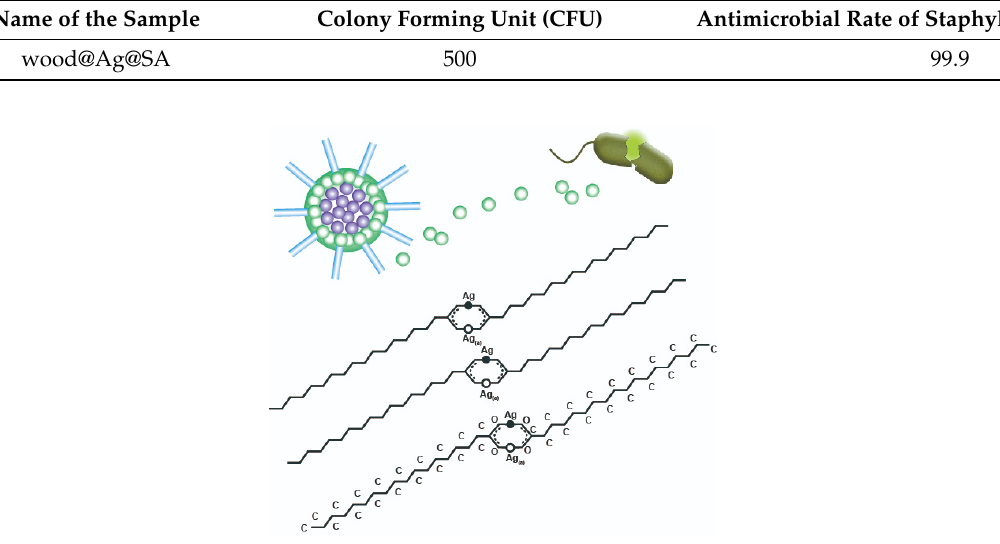
Table 1. The antimicrobial test of wood@Ag@SA.